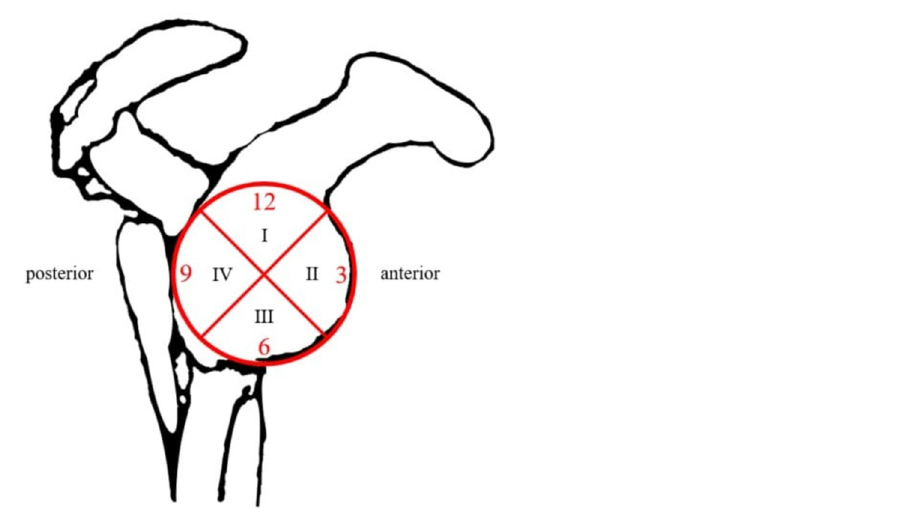
Fig 1. Four zones of the Glenoid (right shoulder). Zone I: 10:30 to 1:30; zone II: 01:30 to 4:30; zone III: 04:30 to 7:30; zone IV: 7:30 to